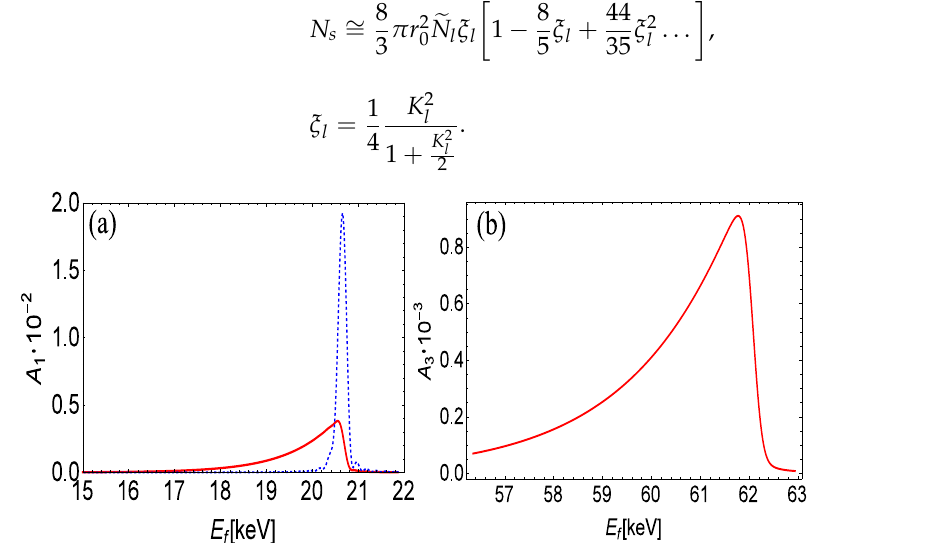
Figure 12. ( a ) A 1 vs. photon Energy, ε n , x , y = 3 × 10 − 7 m · rad , σ ε = 2.5 × 10 − 5 , λ l = 1 µ m, (cid:101) N l = 100, K l = 1, n = 1, β T ( x , y ) = 0.05 m , γ T ( x , y ) = 20 m − 1 , α T ( x , y ) = 0 (continuous), β T ( x , y )